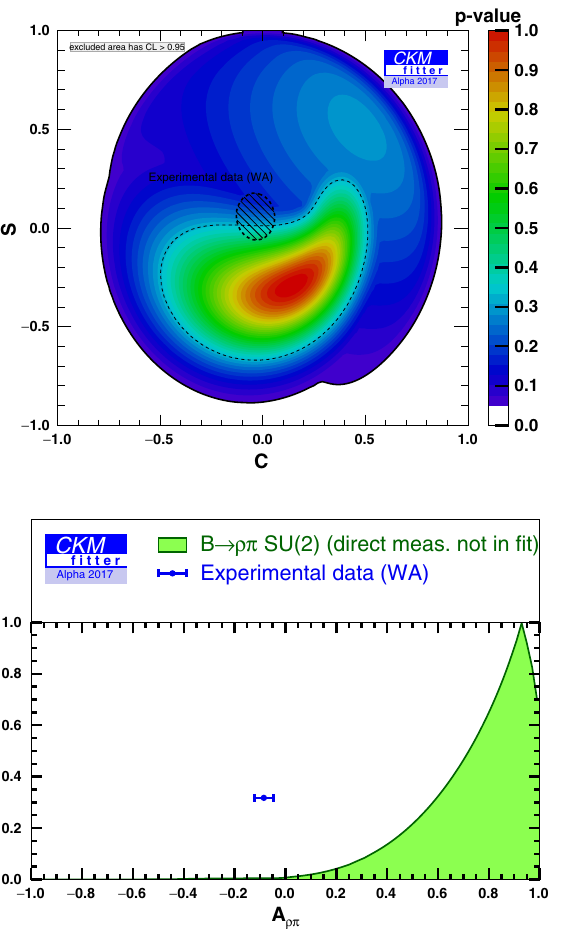
sistent with the indirect determination of α Eq. (2). How- ever, only the solution for α eff near 45 ◦ remains once the Q2B observables and the interference-related constraints for B 0 → ρ ± π ∓ are considered altogether. The solutions close to 0 ◦ and 90 ◦ are disfavoured at 2 . 5 σ . The rejection of these solutions is slightly reinforced with the addition of the observables related to B 0 → ρ 0 π 0